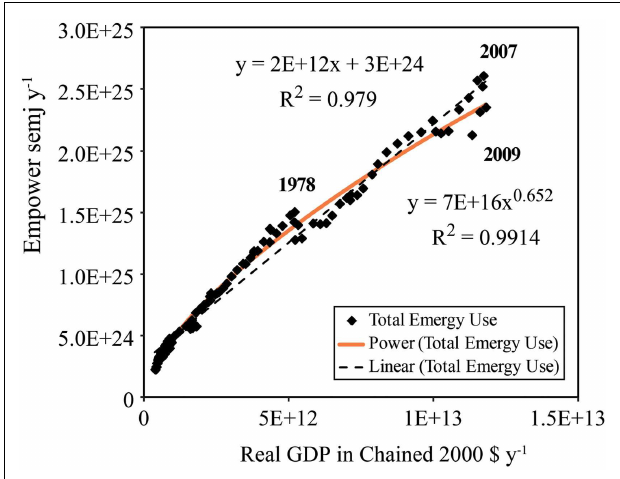
FIGURE 13 | Emergy use or empower (semj/year) continues to follow a power law relationship as real GDP increases